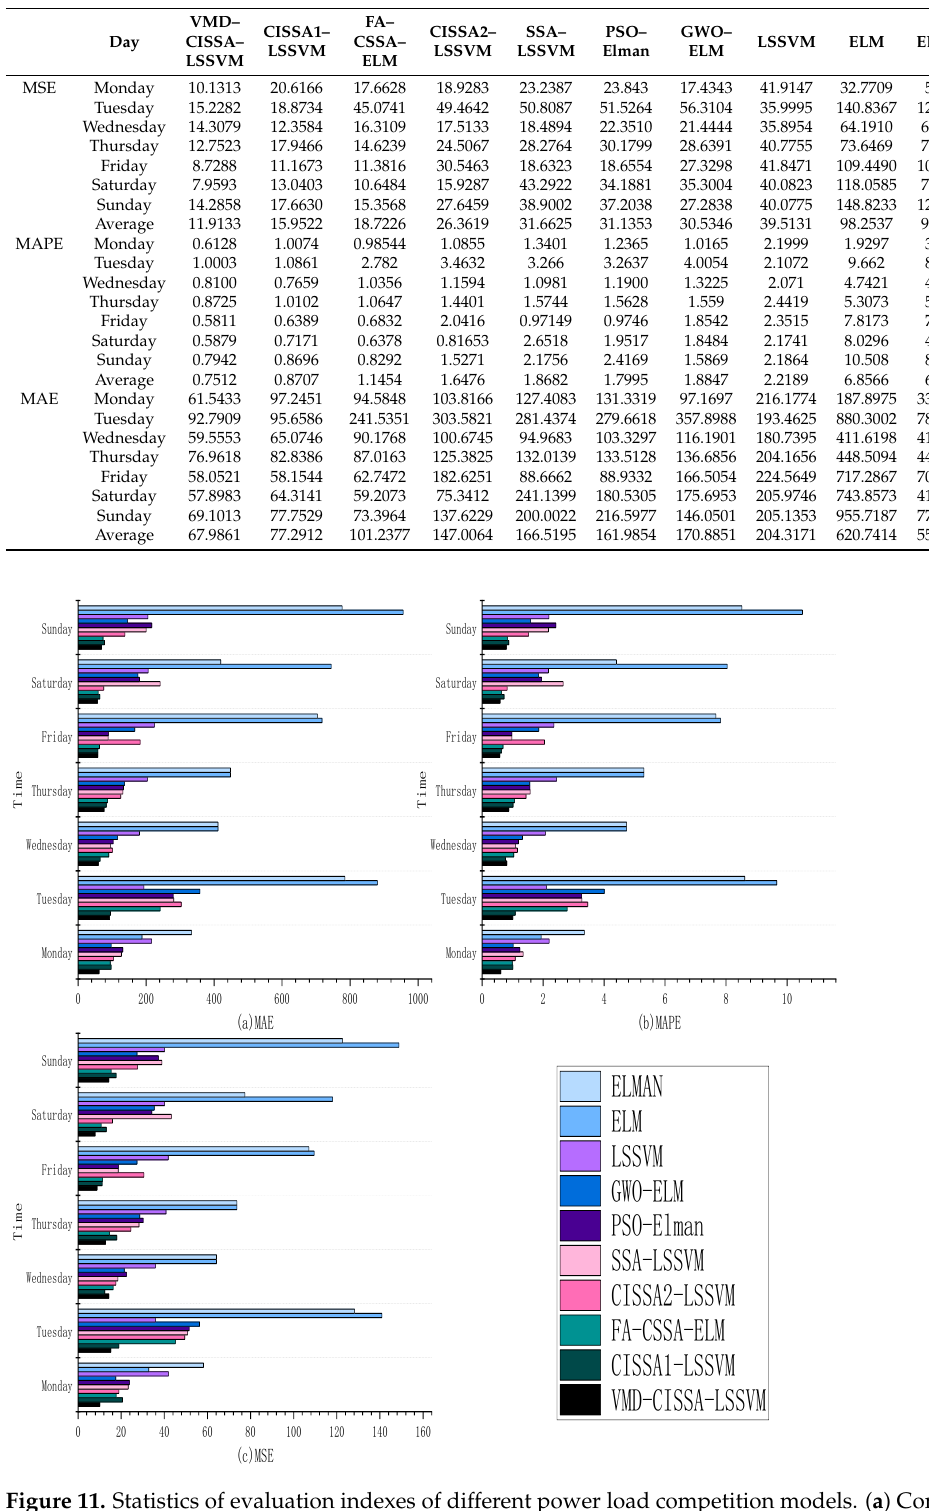
Figure 11. Statistics of evaluation indexes of different power load competition models. ( a ) Compari- son of MAE values for different competition forecasting models; ( b ) comparison of MAPE values for different competition forecasting models; ( c ) comparison of MSE values for different competition forecasting models.